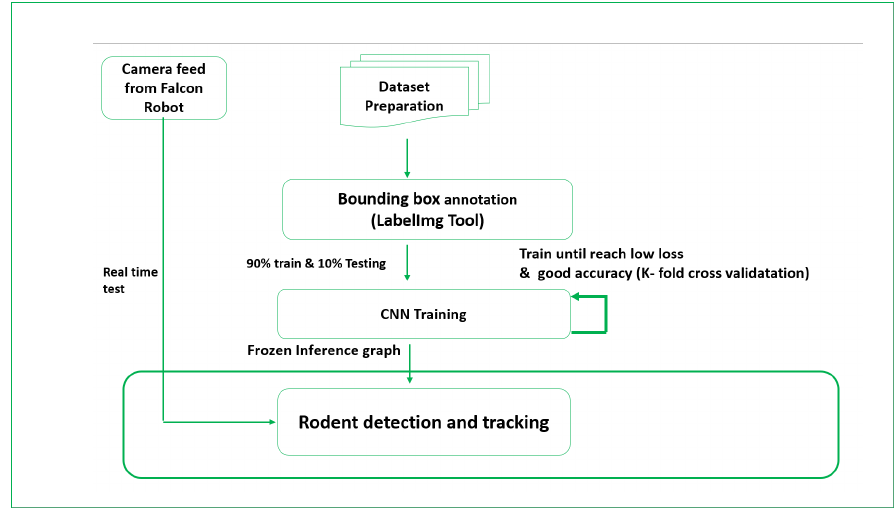
Figure 12. Experimental design